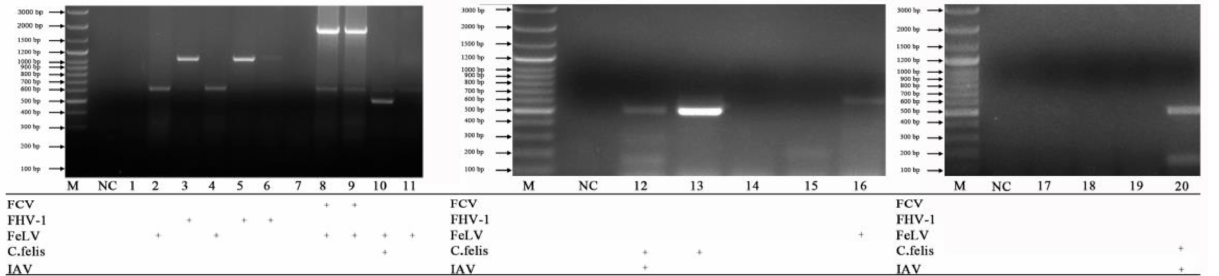
Figure 6. Examination of nasal clinical samples. Lane M, DNA marker (100 bp ladder plus); lane NC, negative control; lanes 1–20, nasal swab clinical